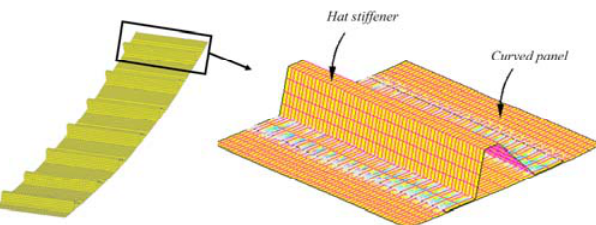
Fig. 8. Curved composite panel and its super-stiffeners